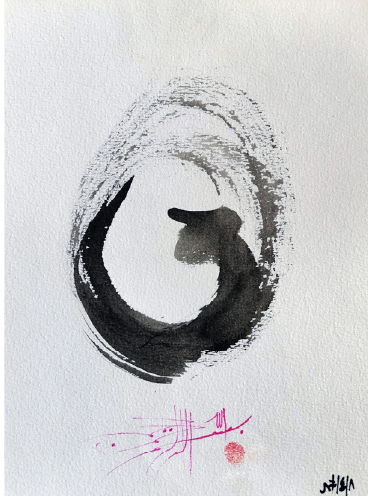
Figure 1. Ahmed Kreusch, Hayy , 1998. Ink on paper. 19 × 24 cm . © Ahmed Kreusch.